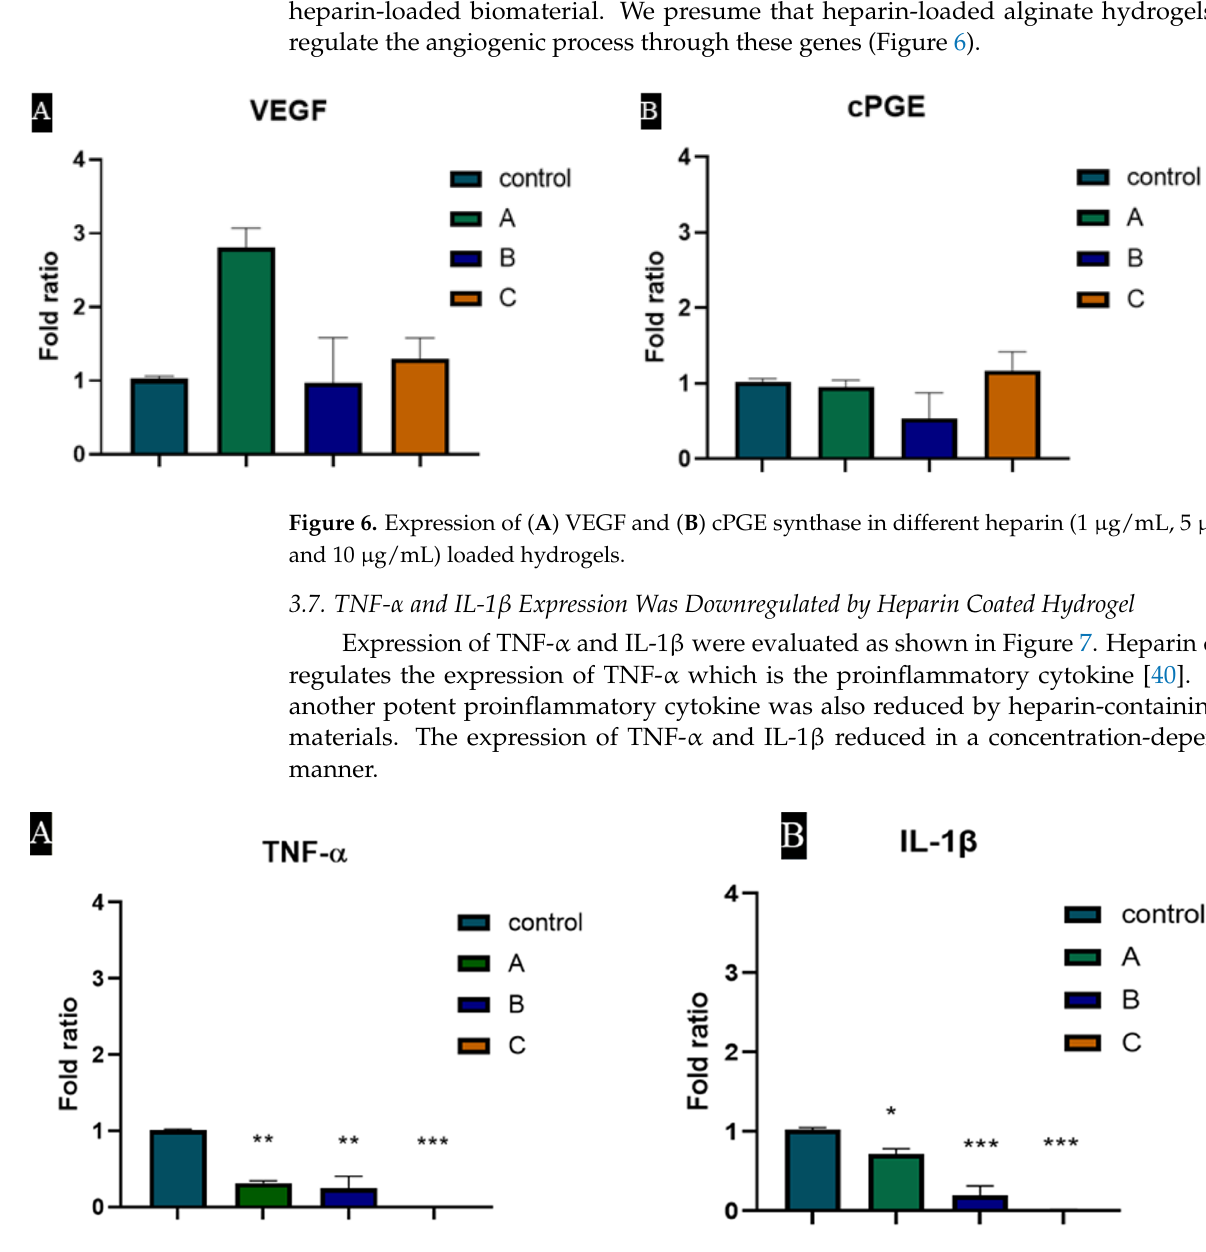
Figure 8. The migration rate of NIH3T3 cells determined by a scratch wound assay where ( A ) rep- resents the microscopic images of migrating cells in different groups while ( B ) is the bar graph rep- resenting the migration rate in each group. Each bar indicates the mean of area covered when com- pared with the control. 4. Discussion Wounds, damaged tissue or skin, can occur in any part of the body, either inside the body or outside. They are painful most of the time and cause discomfort to patients, which makes it difficult for patients to perform daily activities. Wound management is essential for better healing, which includes how to look after them while avoiding complications that can delay the healing process. Most traditional and cost-effective wound dressings only protect the wound from the external environment and do not accelerate the process of wound healing. Although many wound dressings are available in the market that